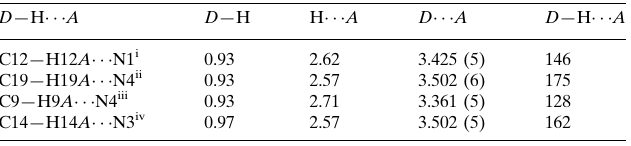
Data collection Bruker SMART APEXII CCD area-detector diffractometer